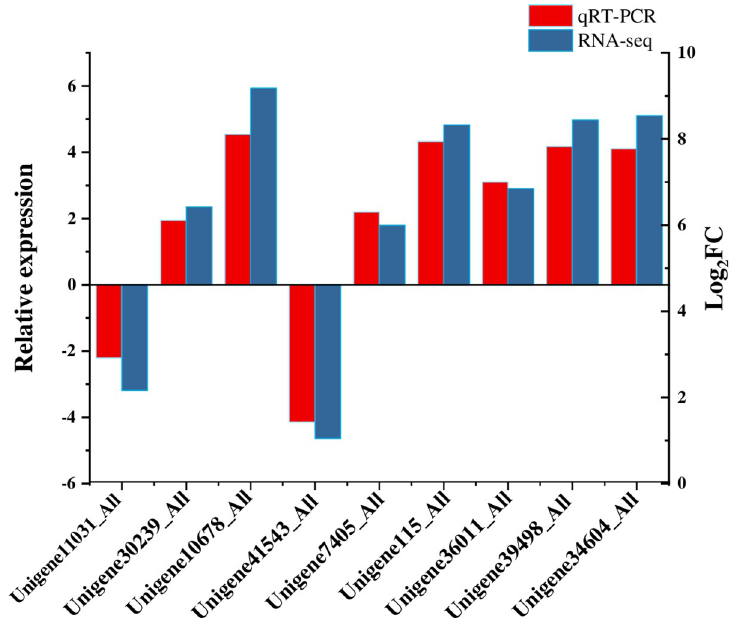
Fig 6. qRT-PCR validation for 9 candidate transcripts. Error bar represents the standard